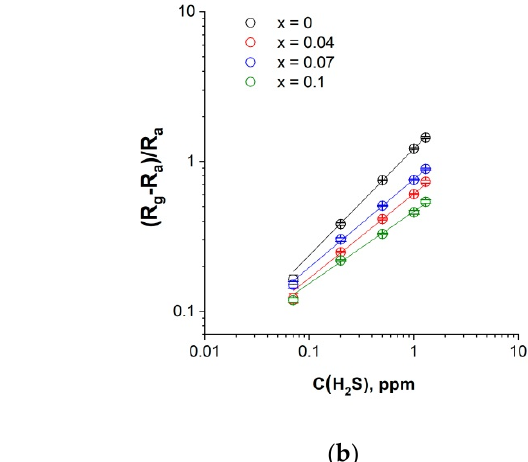
Figure 6. ( a ) The temperature dependence of the sensor signal at the range of 90–300 °C in the presence of H 2 S (1 ppm) in dry air; ( b ) Dependence of the sensor signal value on the concentration of H 2 S at 210 °C in dry air.